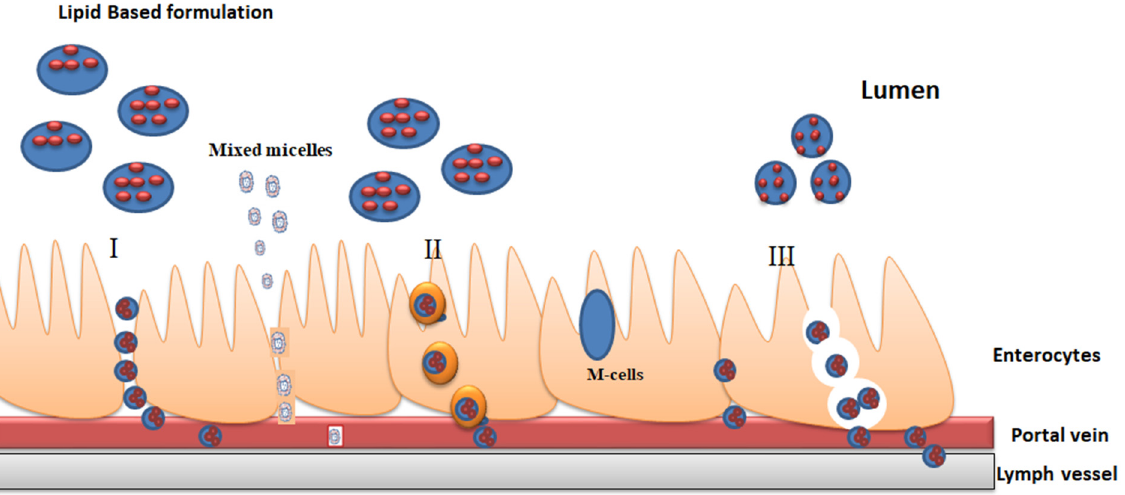
Figure 1. Representation of drug absorption via an enterocyte-based transport mechanism. I—Paracellular transport, II—Receptor-mediated transcellular transport and